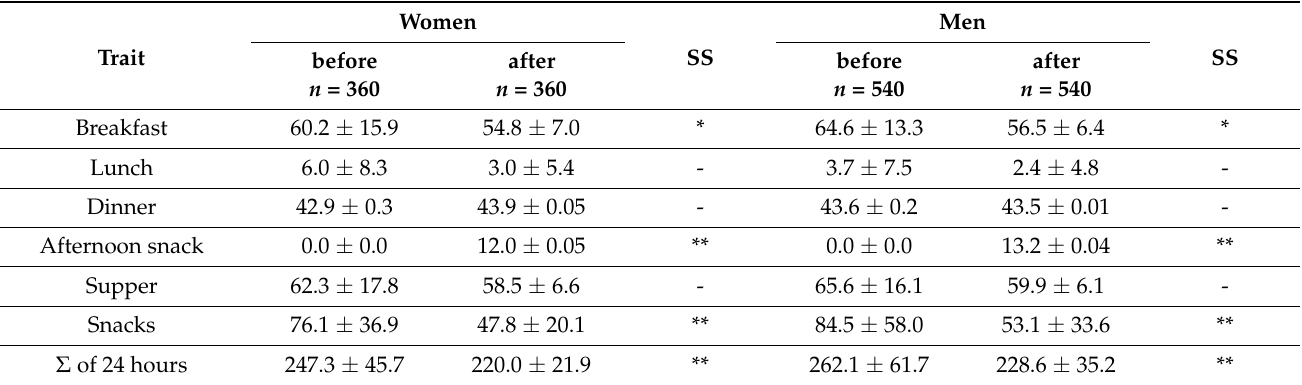
Table 4. The impact of changes in the diet on the value of the glycemic load, including disc remnants, − of women and men; x ±